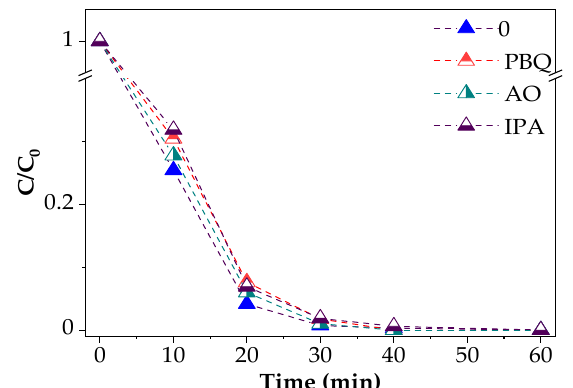
Figure 6. The degradation curves of DCFNa using STO_15_SCO with and without addition of scavengers.